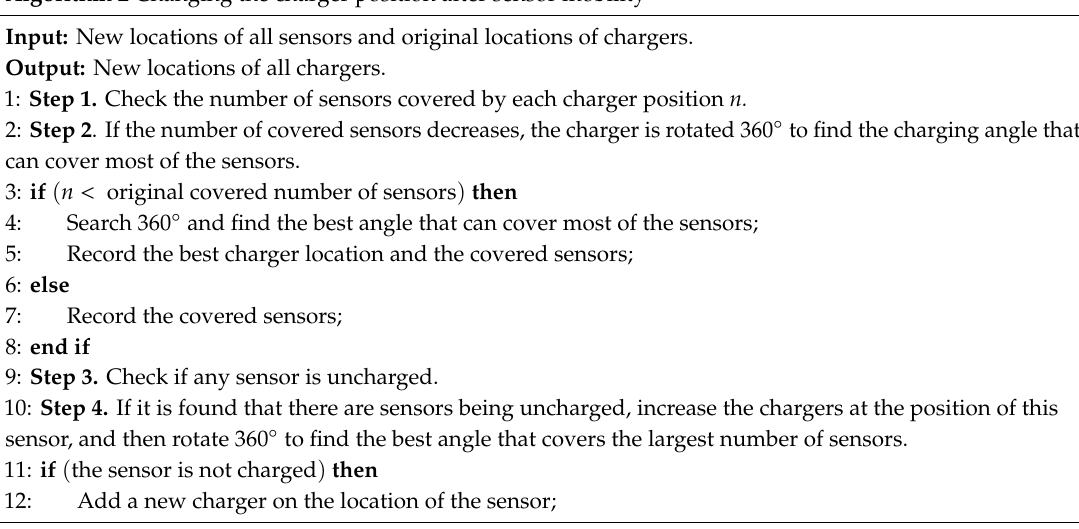
Algorithm 2 Changing the charger position after sensor